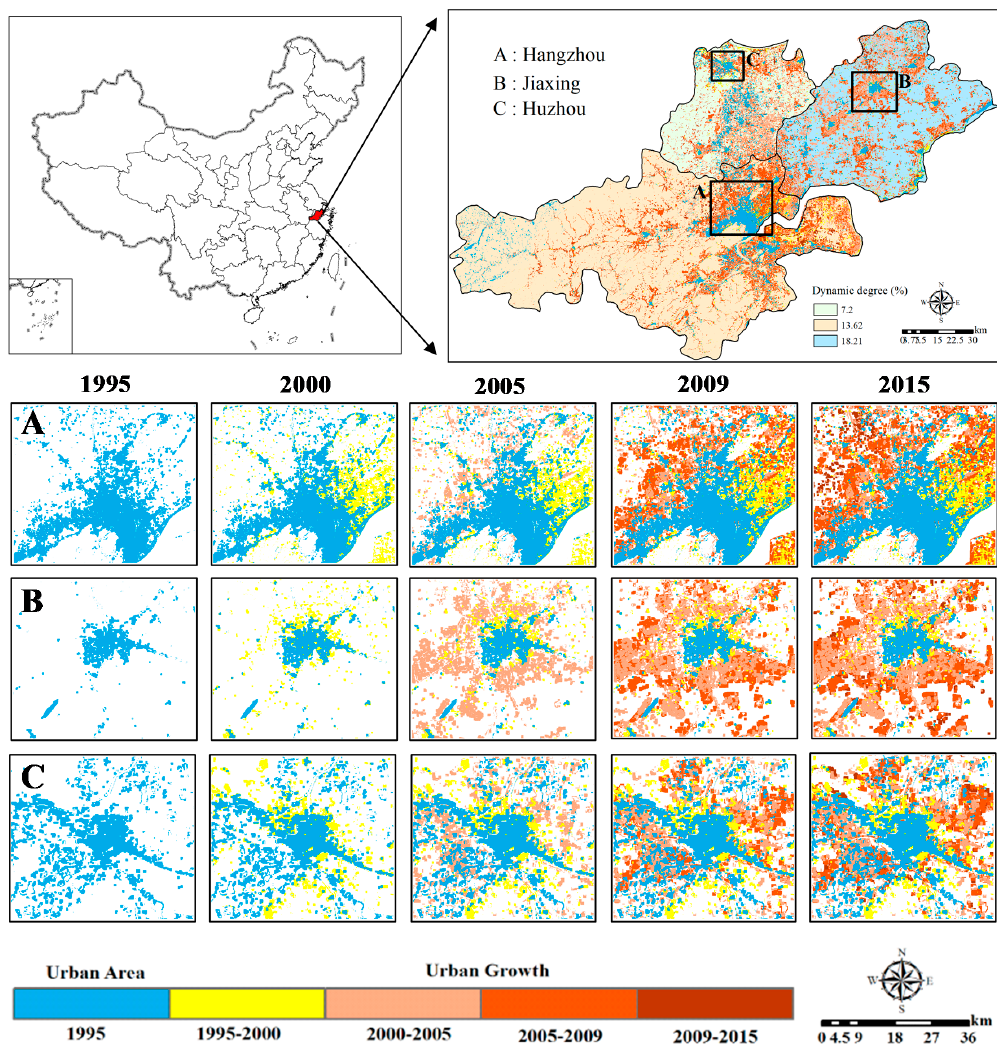
Figure 5. Spatiotemporal distribution of urban growth in Hangzhou ( A ), Jiaxing ( B ) and Huzhou ( C ) from 1995 to